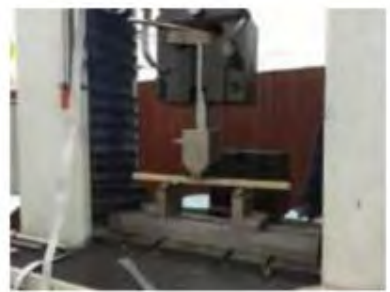
Figure 23. The Bending Procedures in the testing machineb (Author’s own, n.d.)